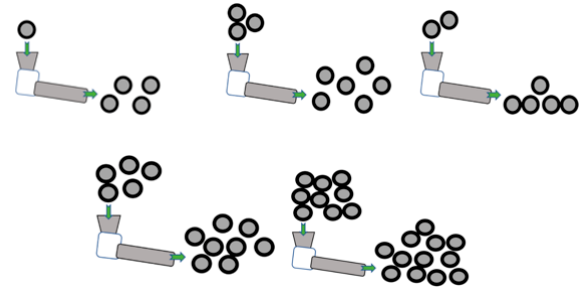
Figure 6. Near specific cases used in the interview.